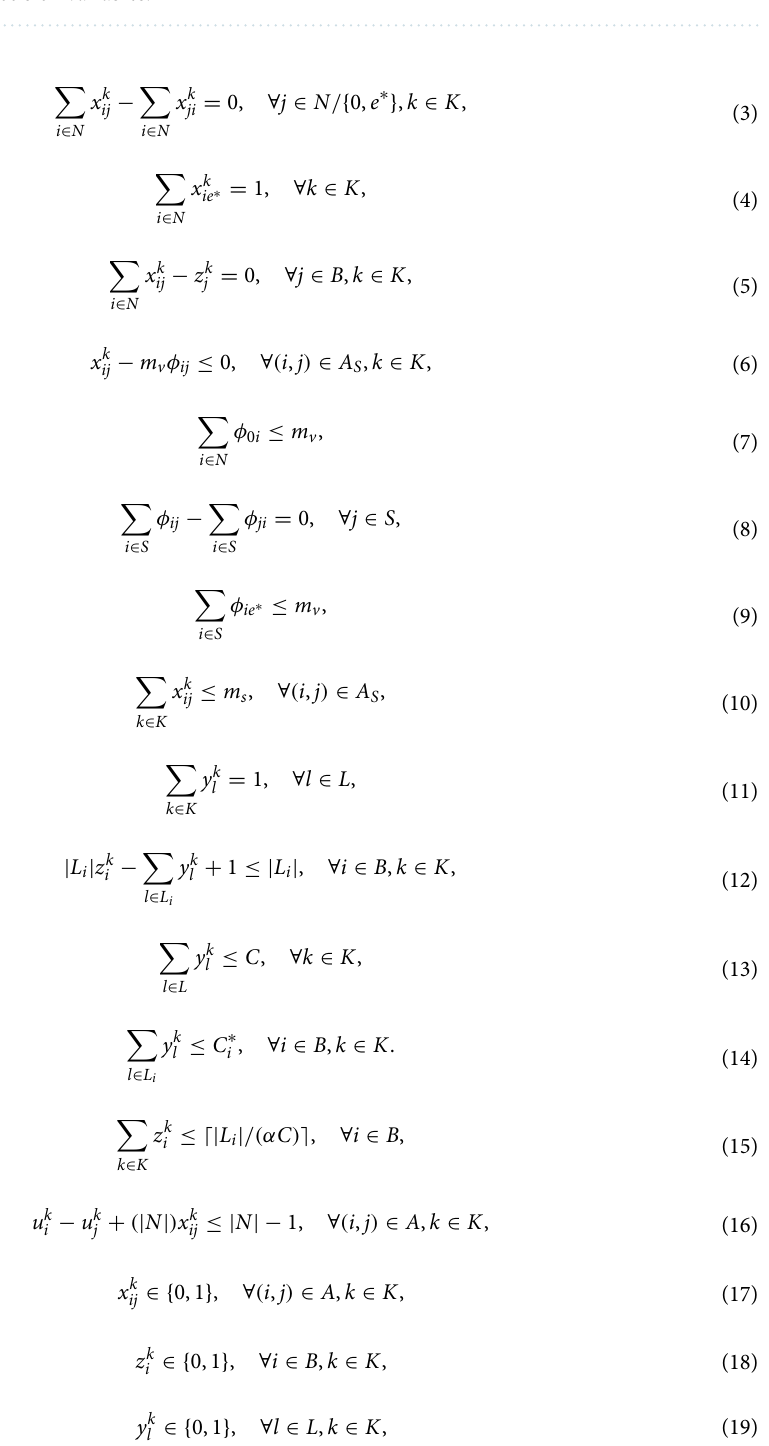
Table 3. Definitions for decision